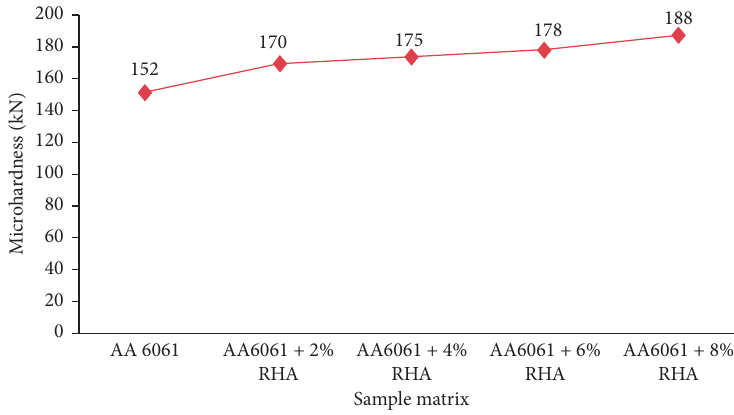
Figure 9: Effect of RHA content on